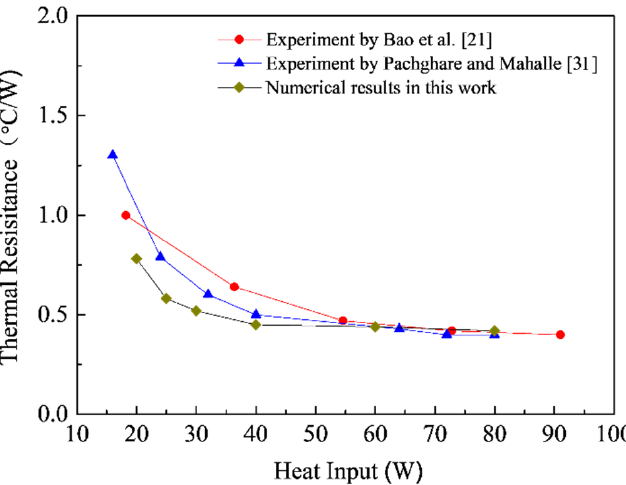
Figure 4. Comparison of the numerical results and the previous experimental results